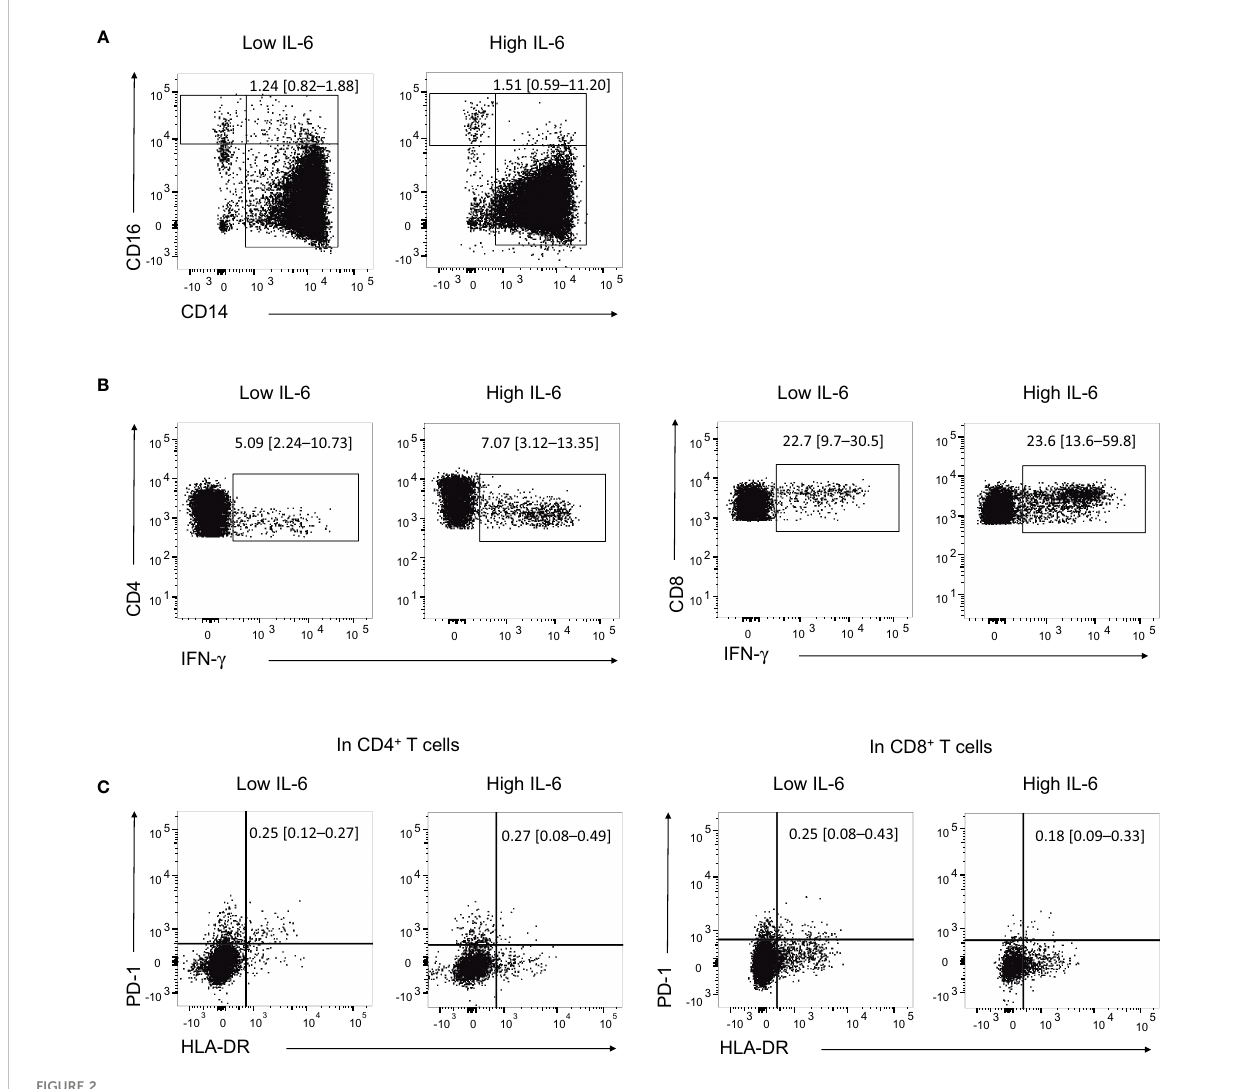
FIGURE 2 Proportion of monocyte subpopulation and expression levels of cytokine and activation markers in T cells. (A) Representative fl ow cytometry dot plots showing the identi fi cation of intermediate monocytes (CD14 + CD16 + ) in the high IL-6 ( n = 5) and low IL-6 ( n = 4) groups. (B) Representative fl ow cytometry dot plots showing the identi fi cation of IFN- g + CD4 + T cells and CD8 + T cells in the high IL-6 and low IL-6 groups. (C) Representative fl ow cytometry dot plots showing the identi fi cation of HLA-DR + PD-1 + CD4 + T cells and CD8 + T cells in the high IL-6 and low IL-6 groups. Numbers indicate population frequencies as the median with interquartile